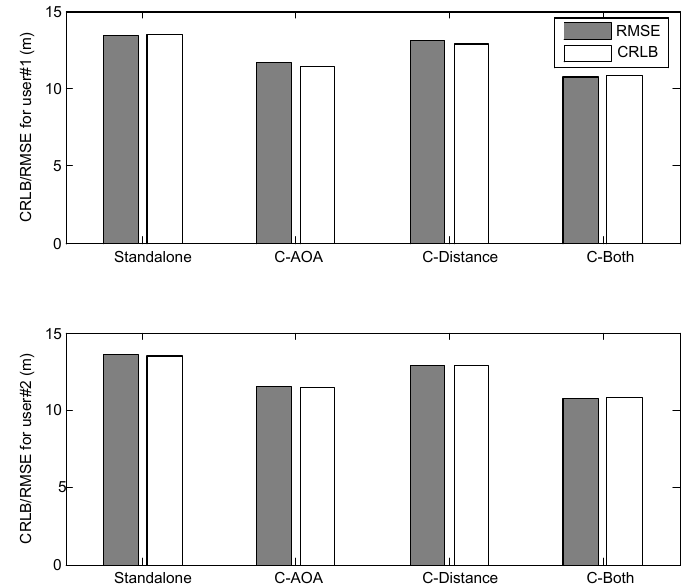
Figure 3. The Cramer–Rao lower bound (CRLB)/RMSE of the outdoor simulation